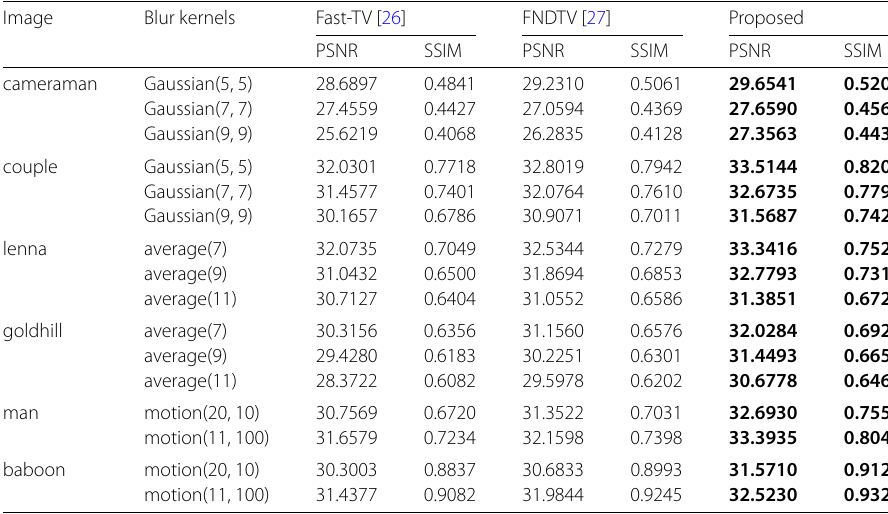
Table 2 Experimental results for different images and different blur kernels, BSNR = 40 Image Blur kernels Fast-TV [26] FNDTV [27] Proposed PSNR SSIM PSNR SSIM PSNR SSIM